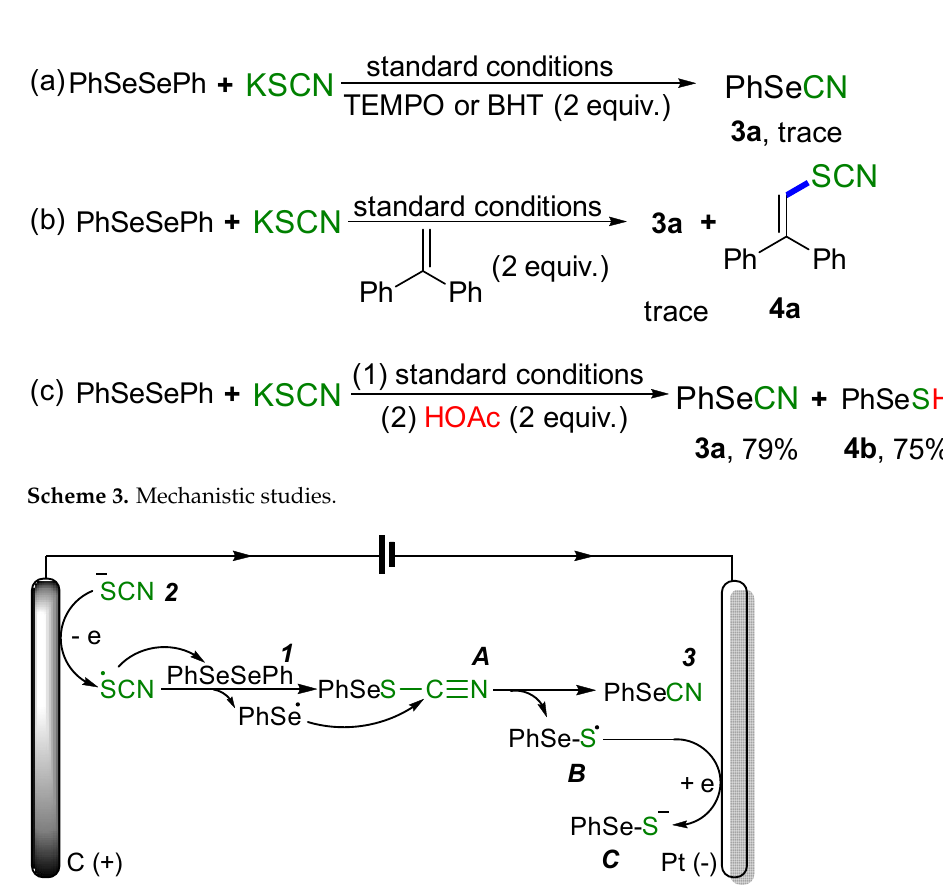
Figure 1. Cyclic voltammetry experiments.